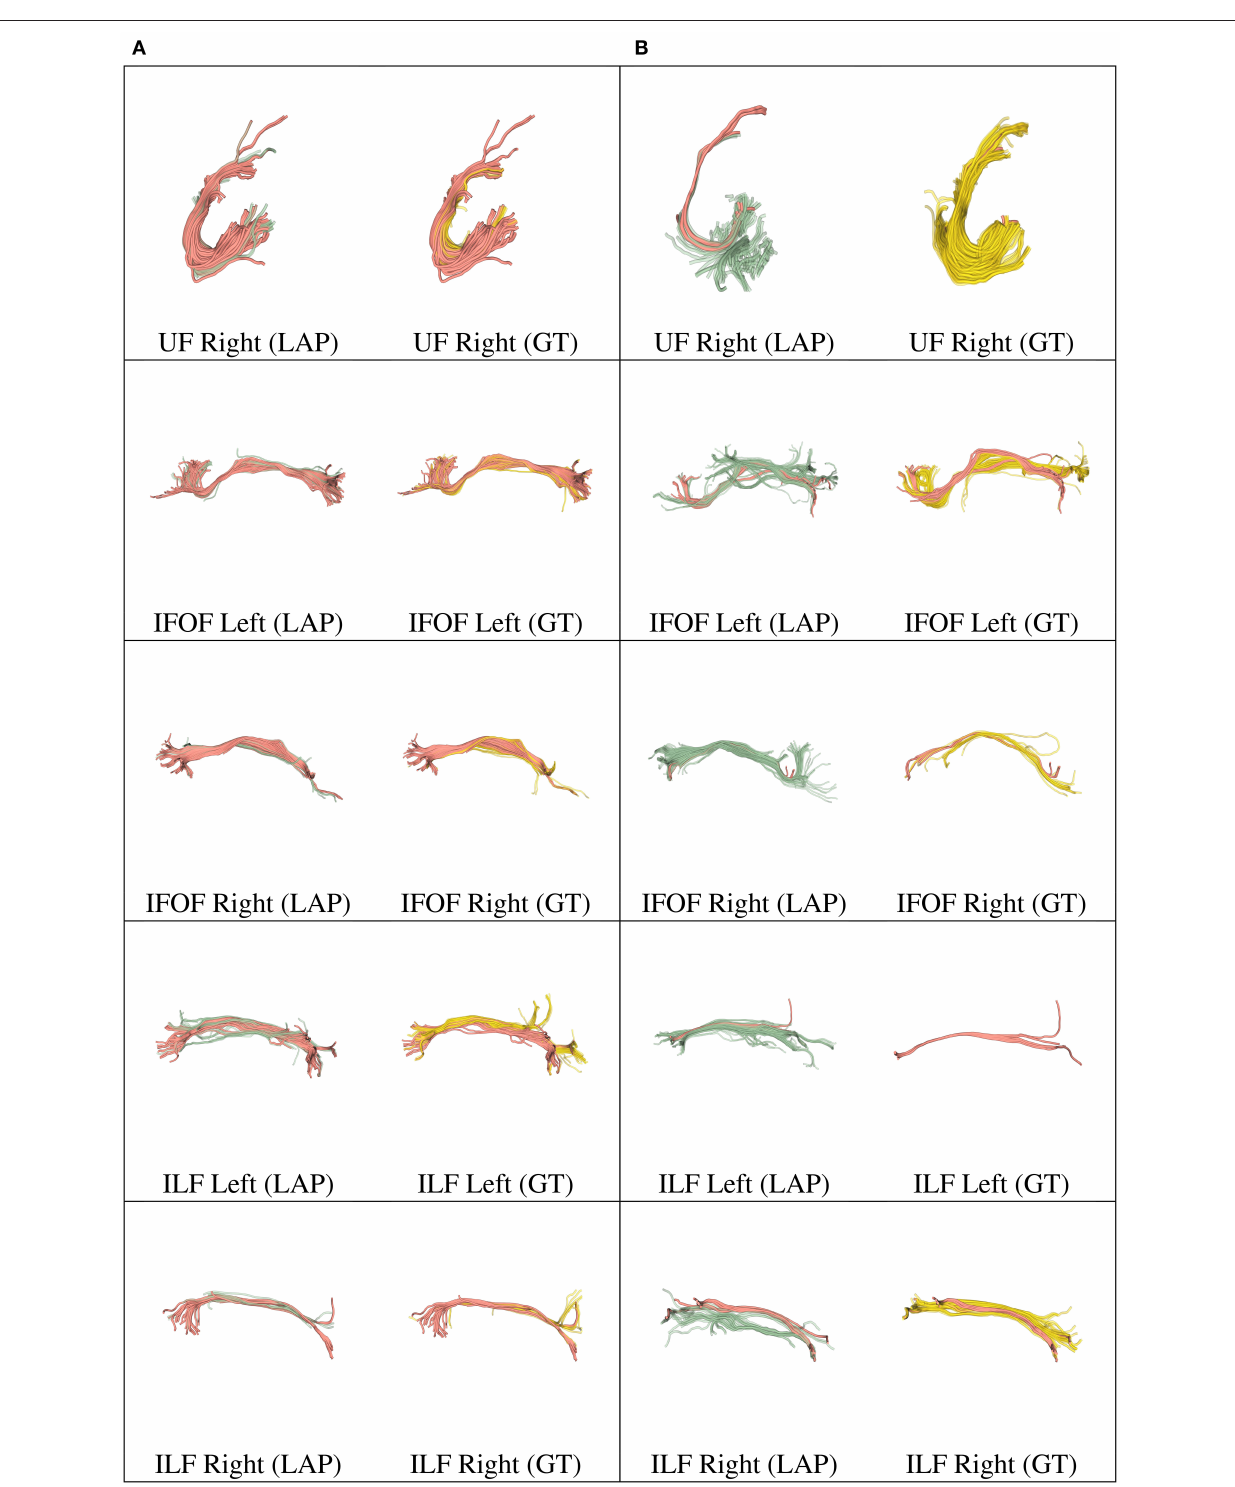
Frontiers in Neuroscience | www.frontiersin.org